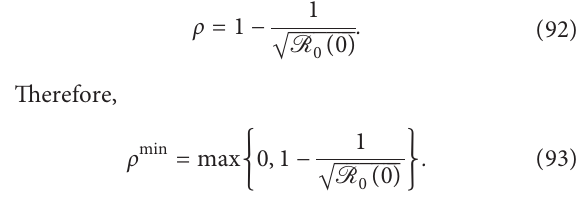
≤ 1 < R and R Z ≤ 1 < R 0 0 1 1